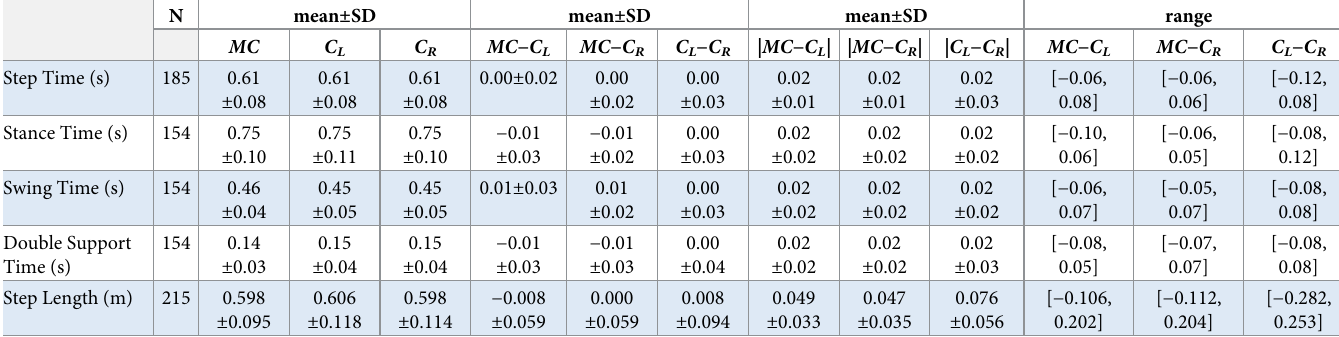
: OpenPose left-side view; C L